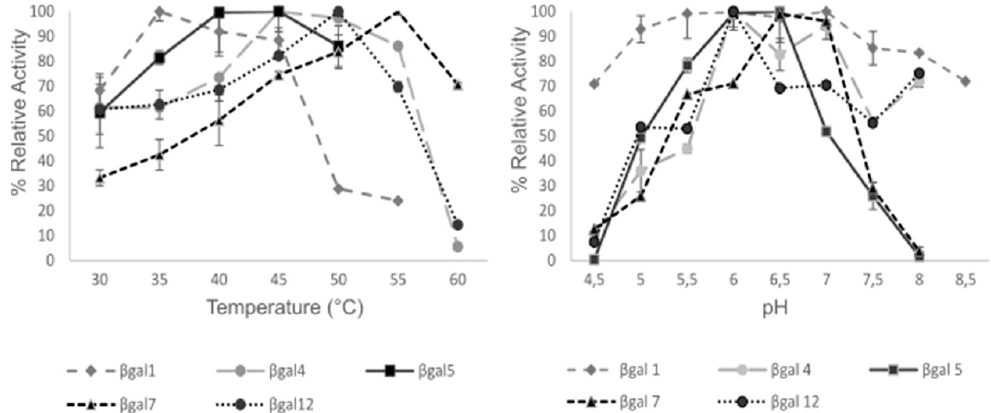
Figure 3. Optimal pH and temperature for β -galactosidases. Enzyme activities were measured by using ONPG as the substrate. The higher activity value for each enzyme was considered as 100%. Data were obtained from biological replicates ( n = 3); the error bars indicate standard deviation.